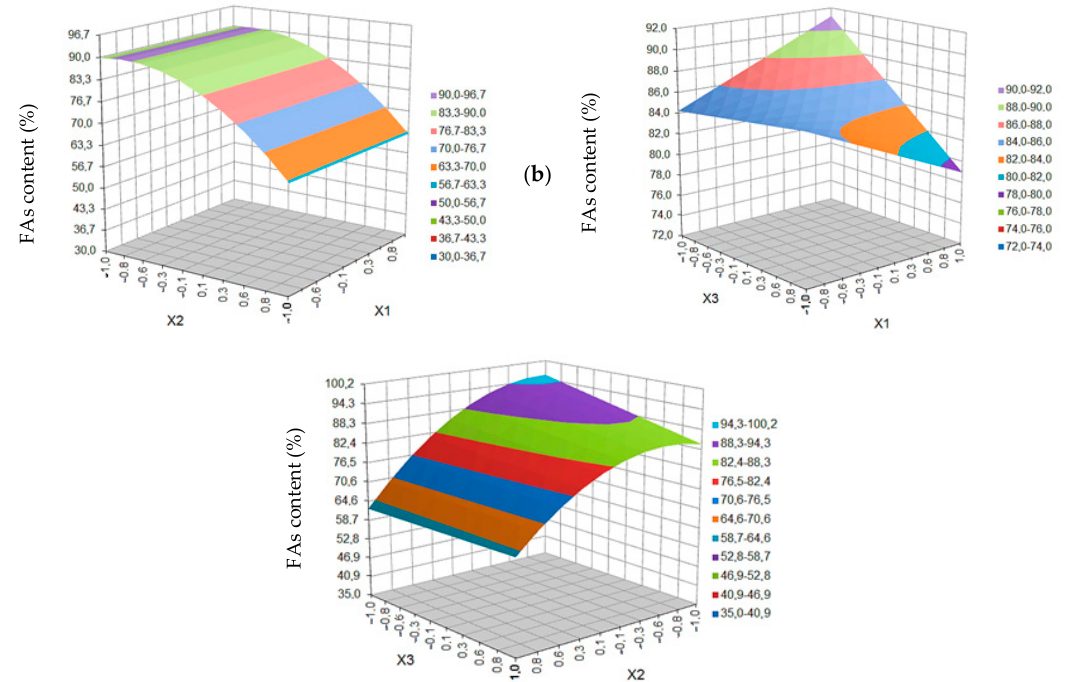
Figure 6. Response surface plot for fatty acid content in black cumin extract as a function of: ( a ) temperature ( X 1 ) and extraction pressure ( X 2 ), ( b ) temperature ( X 1 ) and extraction time ( X 3 ), ( c ) pressure ( X 2 ) and time extraction ( X 3